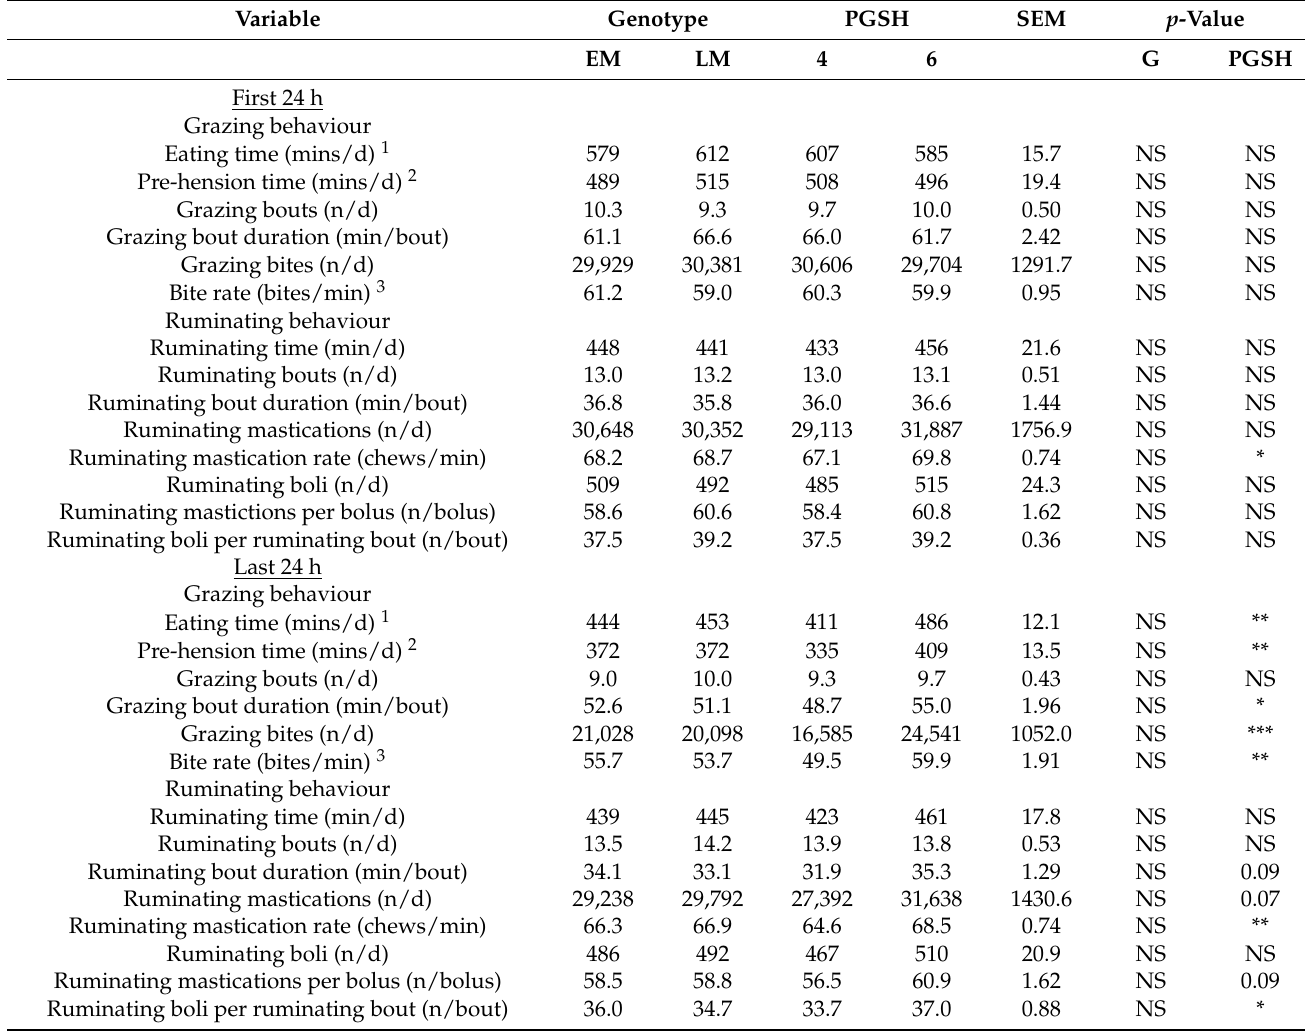
Table 4. Effect of genotype (G-early-(EM) or late-maturing (LM)) and post-grazing sward height (PGSH-4 or 6 cm) on grazing and ruminating behaviour from the RumiWatch system output during the first and last 24 h of a 48-h